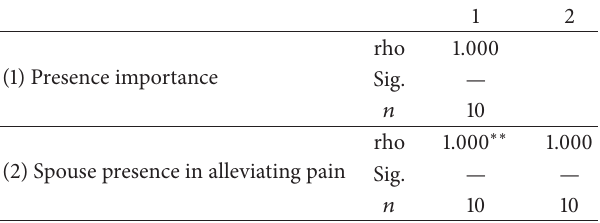
Table 6: Spearman’s rho items correlations of Abuja Instrument for Parturient Pain